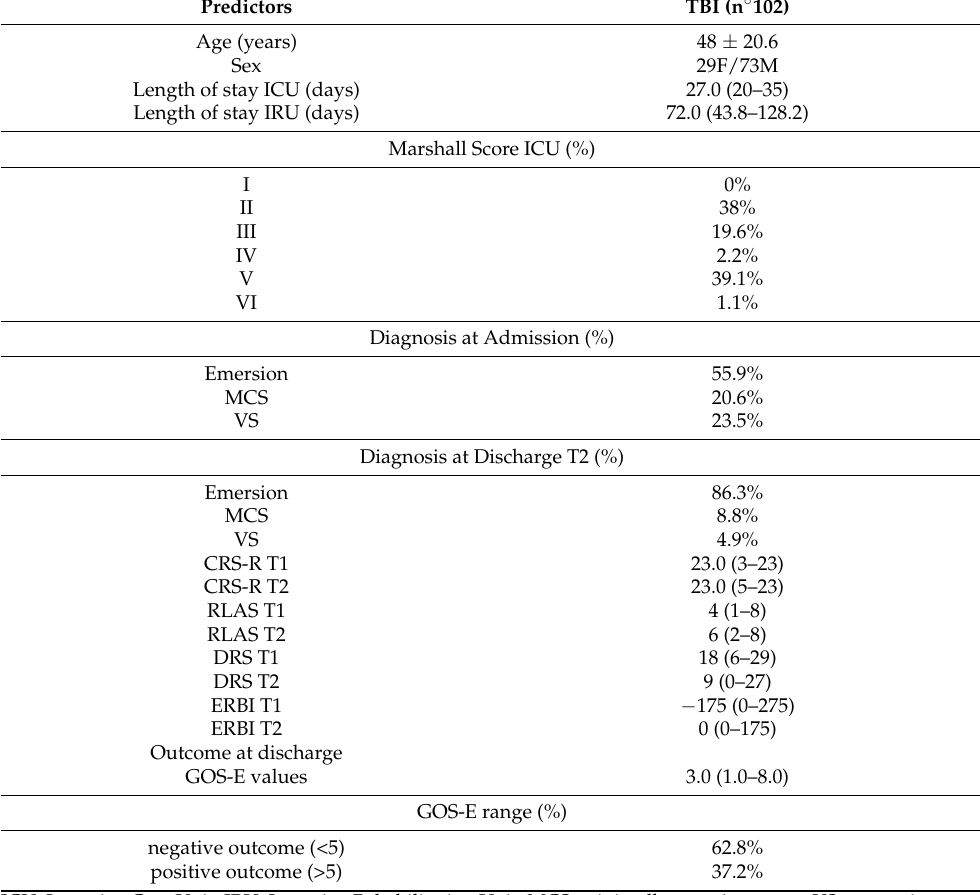
Table 1. Clinical characteristics of TBI